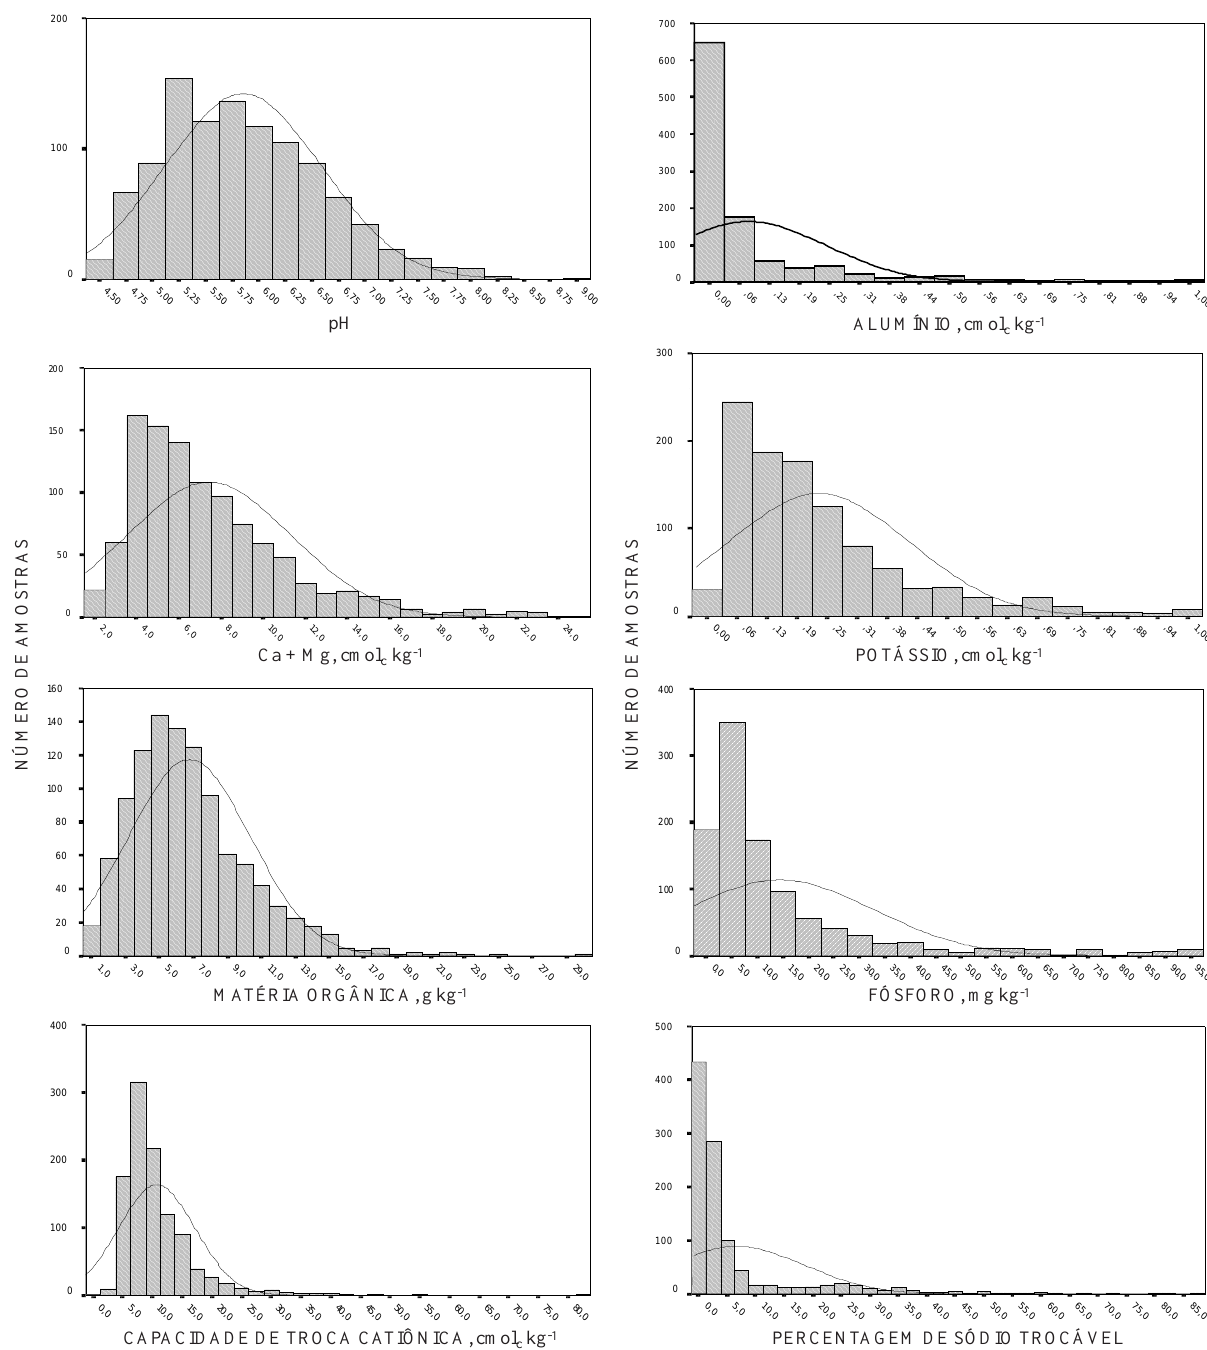
Figura 1. Histograma de freqüência e linhas de distribuição normal para os dados de pH, alumínio, cálcio mais magnésio, potássio, matéria orgânica, fósforo, capacidade de troca catiônica e percentagem de sódio